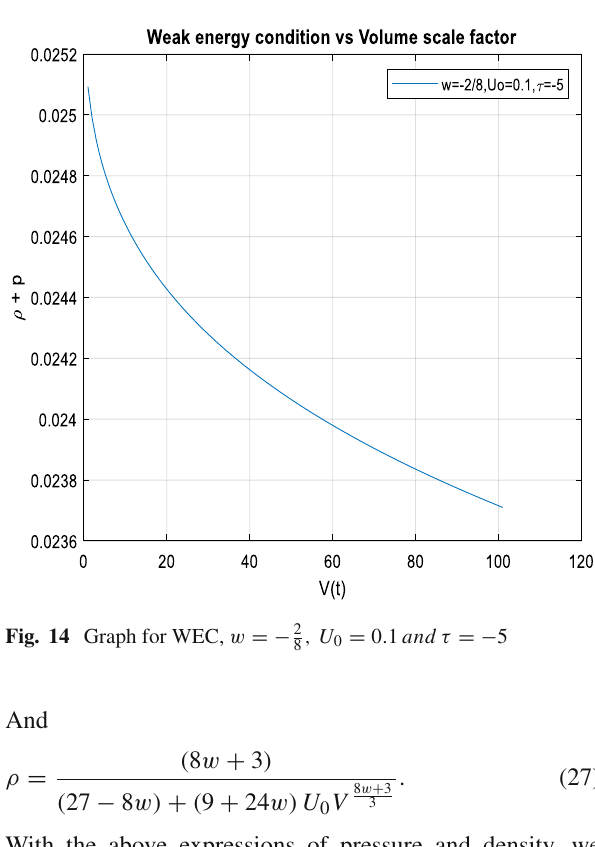
, U = 0 . 1 and τ = − 5 0 8